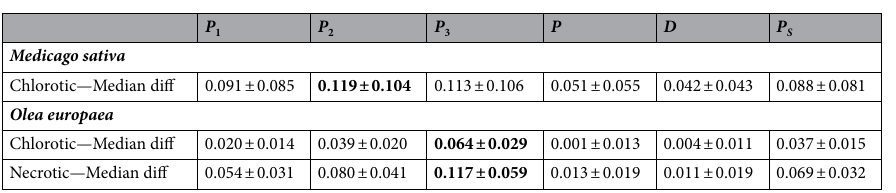
Table 1. Polarimetric observables median value difference and propagated errors for healthy-diseased tissue. The corresponding three largest median difference values are highlighted in bold.